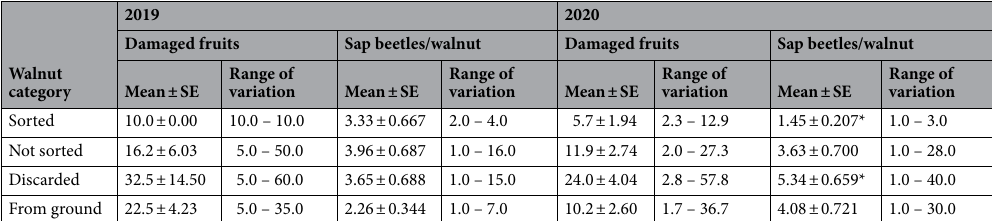
Table 1. Percentage of fruit damaged by sap beetle and mean number of sap beetles per walnut in 2019–2020 in different walnut categories. Sorted: walnut fruits sorted by mechanical and/or manual process; unsorted: walnut fruits harvested, stored in warehouse but not subjected to a sorting process; Discarded: walnut fruits discarded during sorting process; Collected from ground: walnut fruits picked directly from the ground in walnut orchards; * denotes a statistical